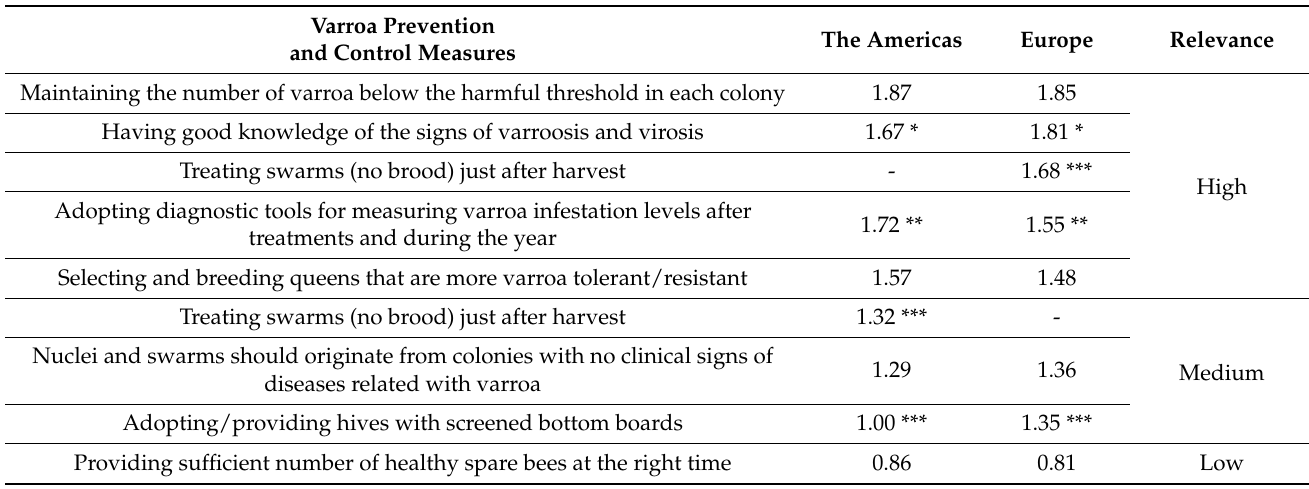
Table 2. Mean values of usefulness of varroa prevention and control measures both in the Americas and in Europe.